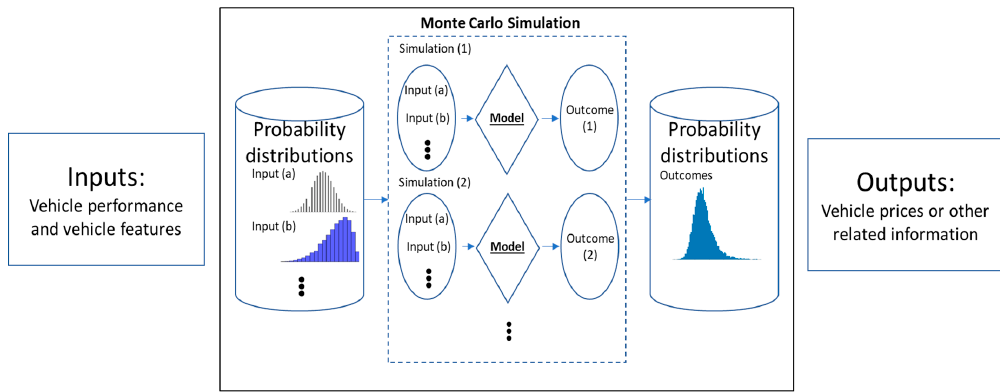
Figure 7. Flow chart of Monte Carlo Simulation.